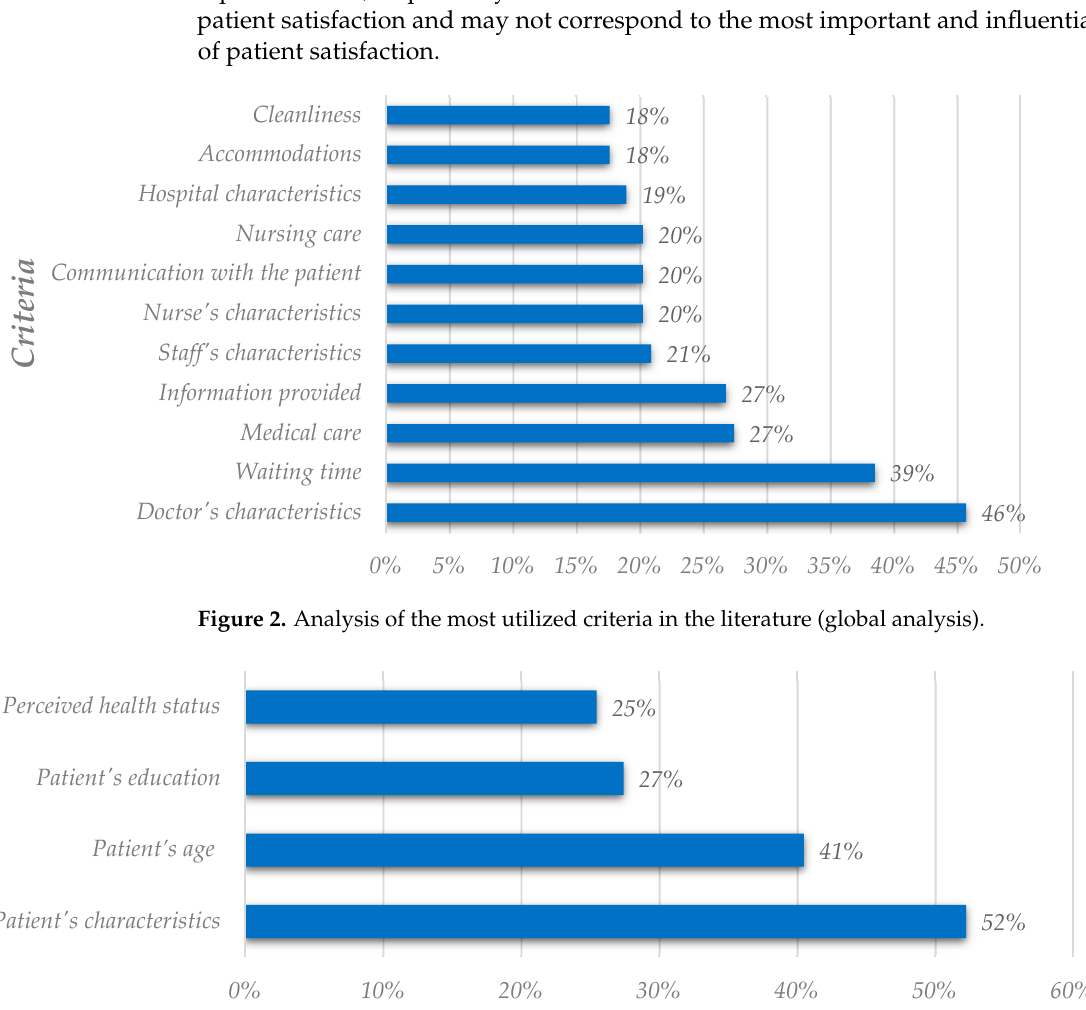
Figure 3. Analysis of the most utilized explanatory variables in the literature (global analysis).